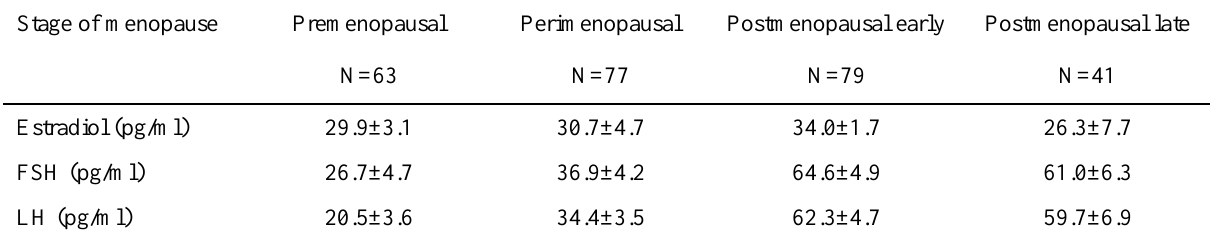
Table 2. Levels of reproductive hormones (by STRAW) stratified by menopausal status Stage of